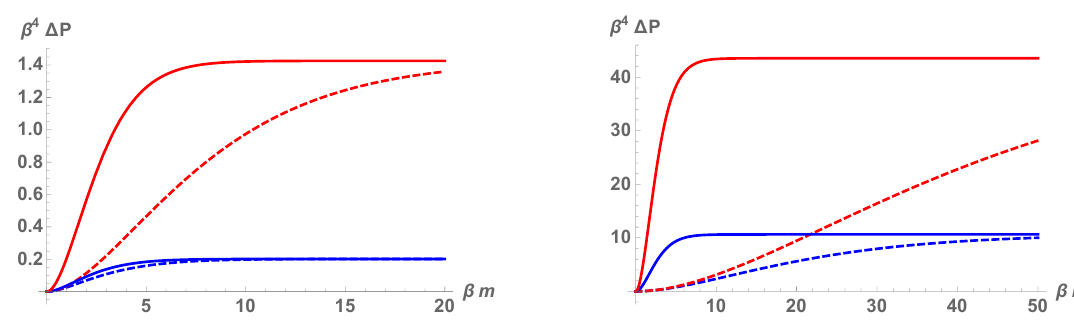
Figure 8 . Comparison of the force on the bubble ∆ P z given by the ballistic approximation (3.39) and the lte approach (3.41) as a function of m/T . Left panel: γ = 1 . 1 (lte: solid blue; ballistic: dashed blue), γ = 2 (lte: solid red; ballistic: dashed red). Right panel: γ = 5 (lte: solid blue; ballistic: dashed blue), γ = 10 (lte: solid red; ballistic: dashed